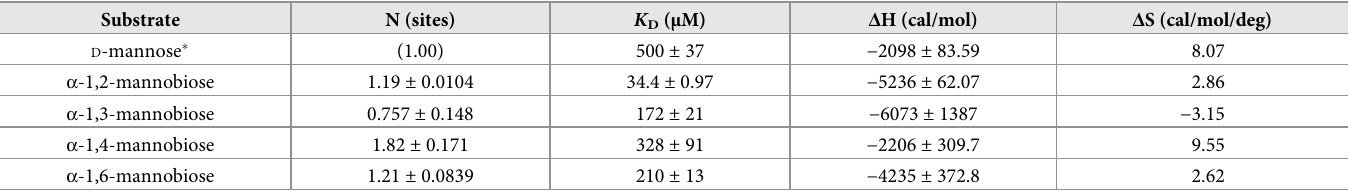
Table 3. Thermodynamic parameters from isothermal titration calorimetry assay.